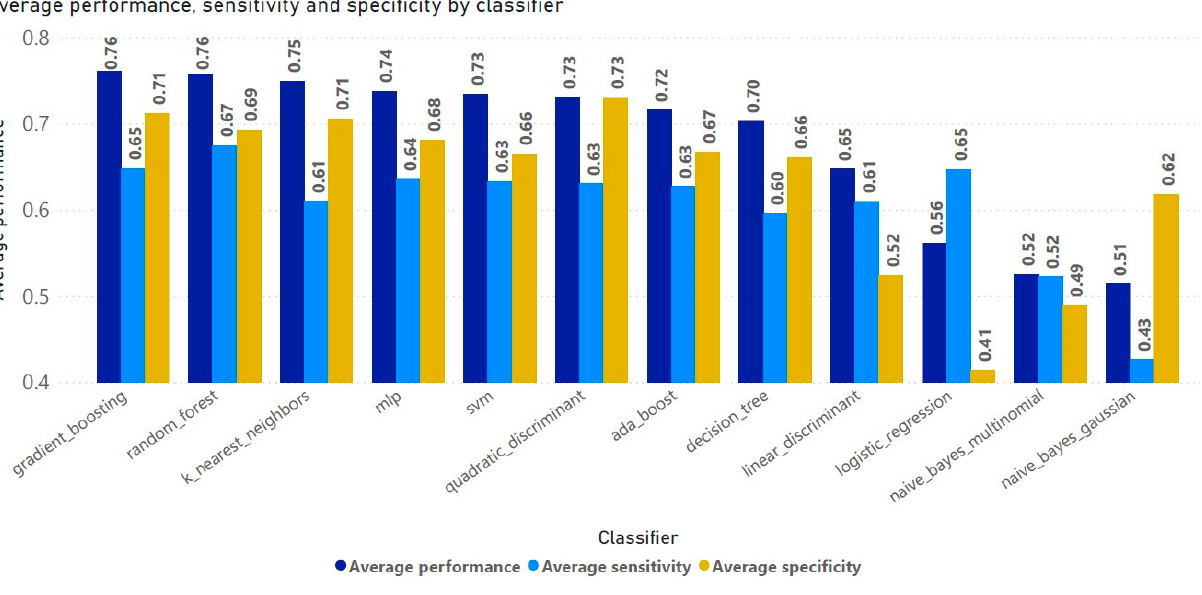
Figure 4. Depiction of average performance (dark blue), sensitivity (light blue), and specificity (yellow) computed from testing on 26 thresholds for each classification algorithm.